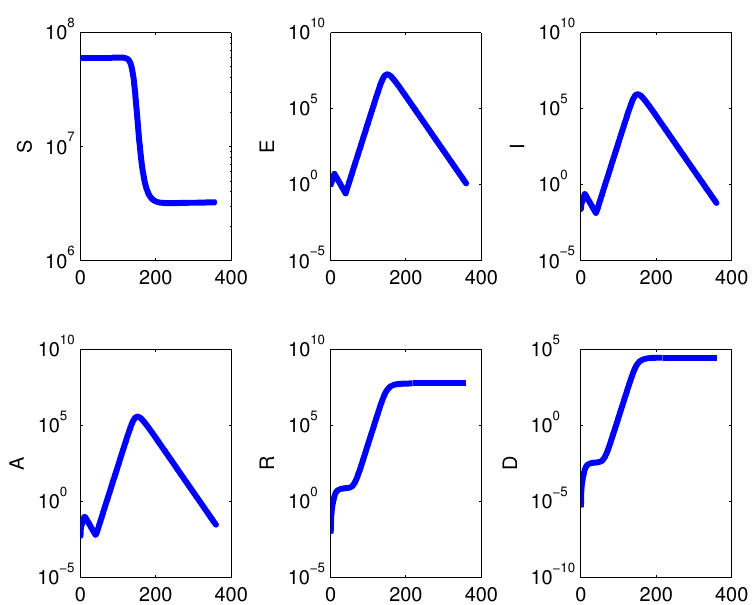
Figure 2. Using a semilogarithmic scale for the vertical axis, we show the results of starting the restrictions at time t 1 = 10, using β I = 10 − 10 and lifting them at time t 2 = 30, returning to β I = 10 − 7 one month later, over a one year timespan for the model with demographics (1). Left to right and top to bottom, the subpopulations are: S , E , I , A , R and D , the disease-related deceased class.